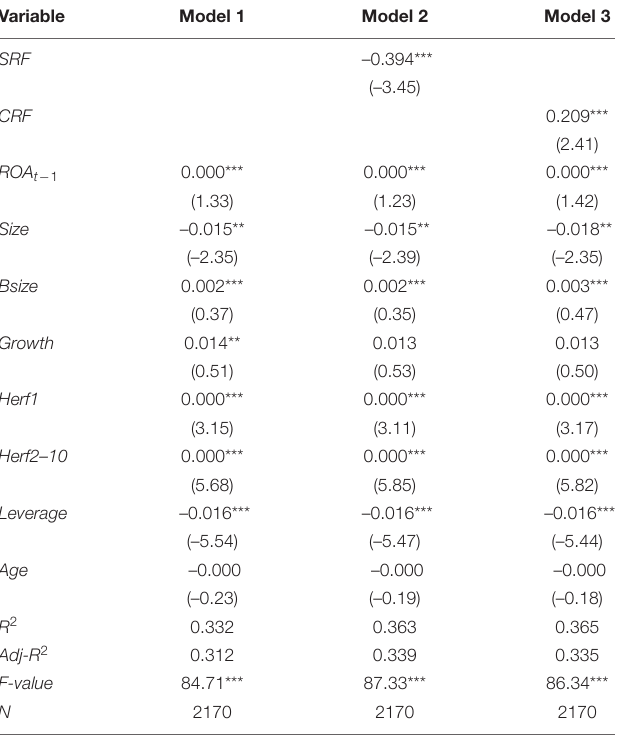
TABLE 3 | Board faultlines and innovation strategy decisions. TABLE 4 | Impact of dual chairman/CEO on the relationship between board faultlines and innovation strategy